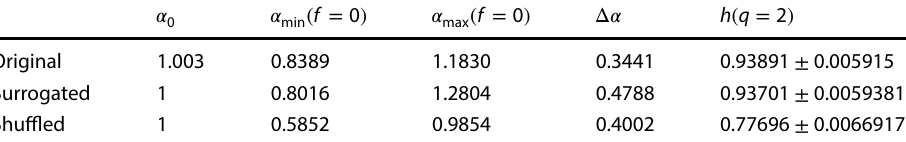
Table 2 Computed outcomes for the original and randomised Planetary K-index